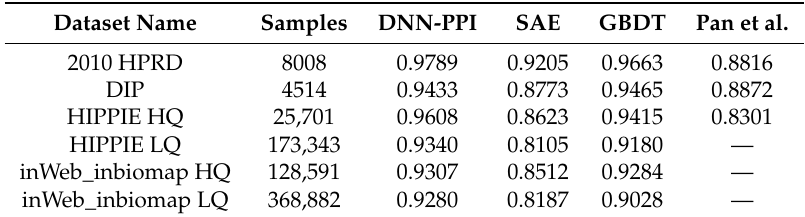
Table 8. Accuracy comparisons on validation datasets.